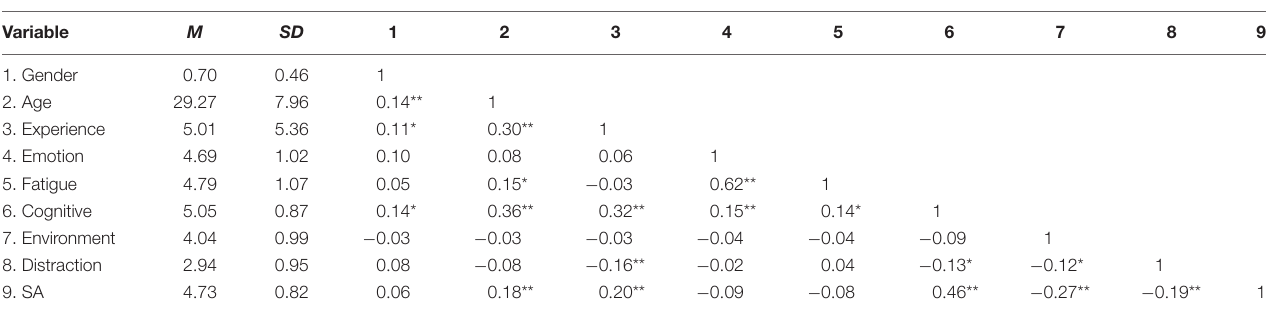
TABLE 3 | Mean, standard deviation, and Pearson correlation coefficient ( N =